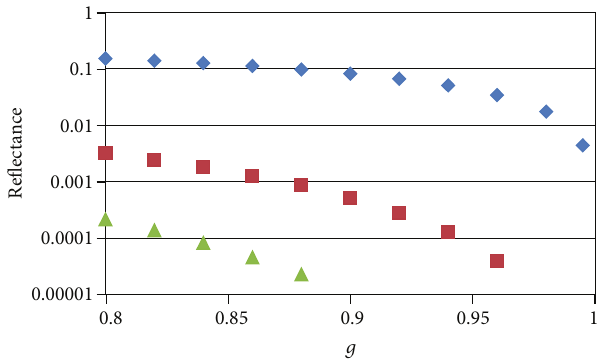
Figure 7: Dependence of single backward scattering (rhomboids), 3-fold (squares) and 5-fold (triangles) backward scattering as a function of 𝑔(𝑎 = 0.95)